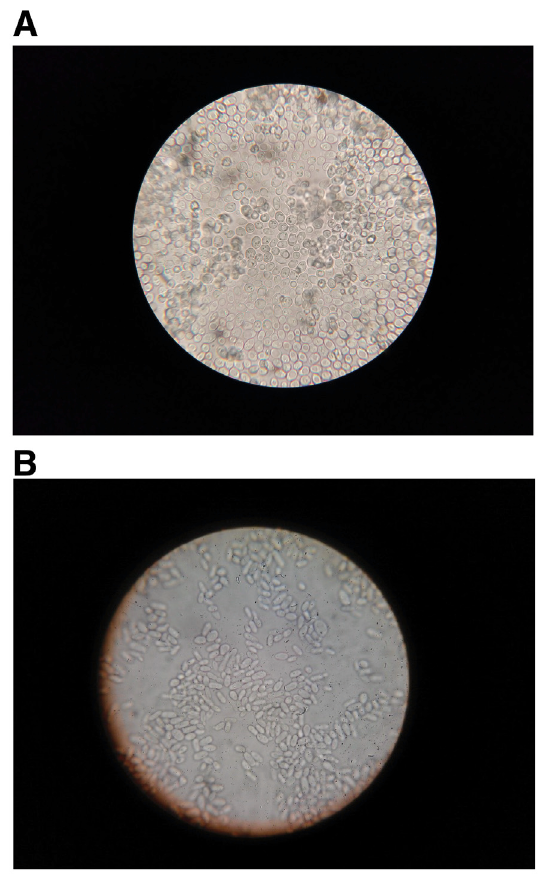
Figure 1. The cell morphology (unicellular ovoid shape, multipolar budding; white and creamy texture) of yeasts under the compound microscope (100X) from sugarcane juice ( A ) and date juice ( B